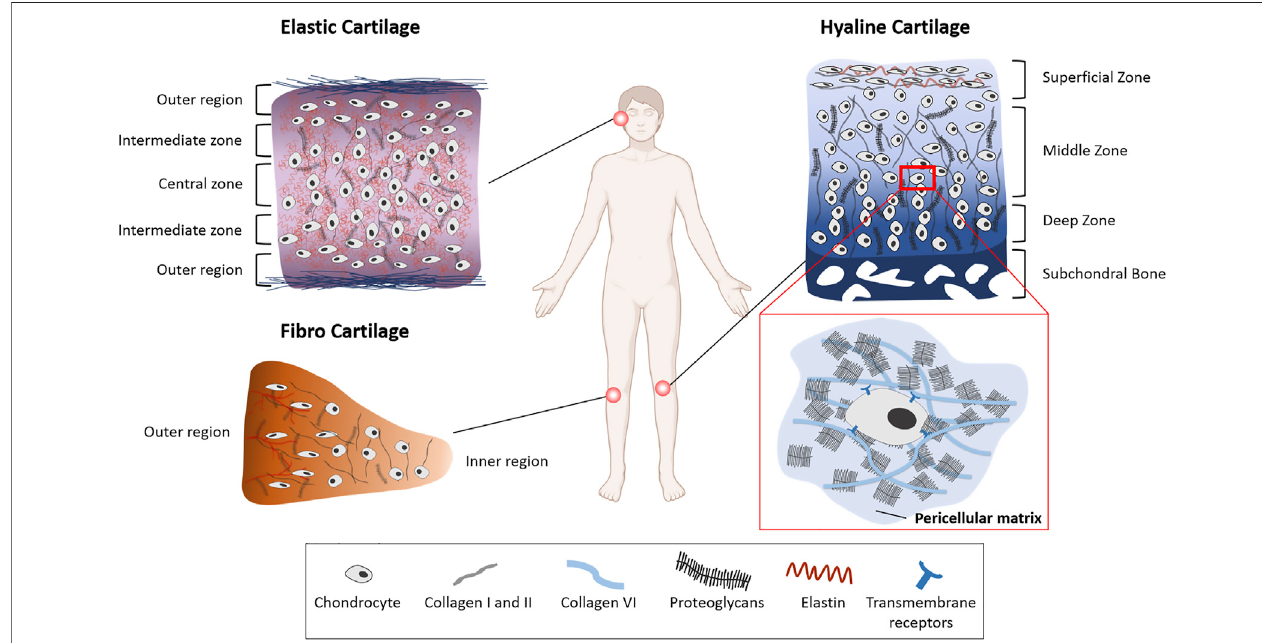
FIGURE1| Extracellularmatrixheterogeneity ofdifferentcartilagetypes. Thethreecartilagetypes varyinECMcompositionandarrangement.Elastic cartilageand hyaline articular cartilage are arranged in different zones with the chondrocyte shape becoming smaller and fl atter towards the outer region and super fi cial zone, respectively. Proteoglycan (PG) concentration articular cartilage in the knee joint increases with depth of the tissue. In meniscal cartilage ( fi bro cartilage) the PG concentration is highest in the outer region. The pericellular matrix (PCM) surrounds the chondrocytes and contains a high amount of PGs such as aggrecan and perlecan, and collagen type VI in articular and meniscal